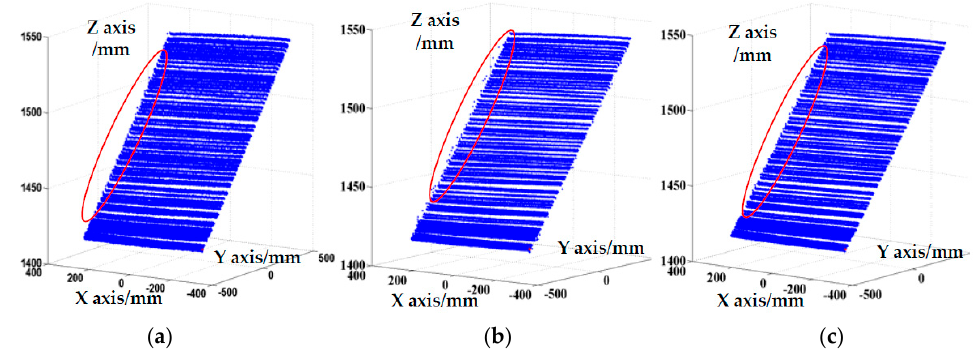
Figure 12. Reconstruction results with different extraction methods. ( a ) Geometric center method; ( b ) Centroid of Gray (COG); ( c ) feature compression extraction method.